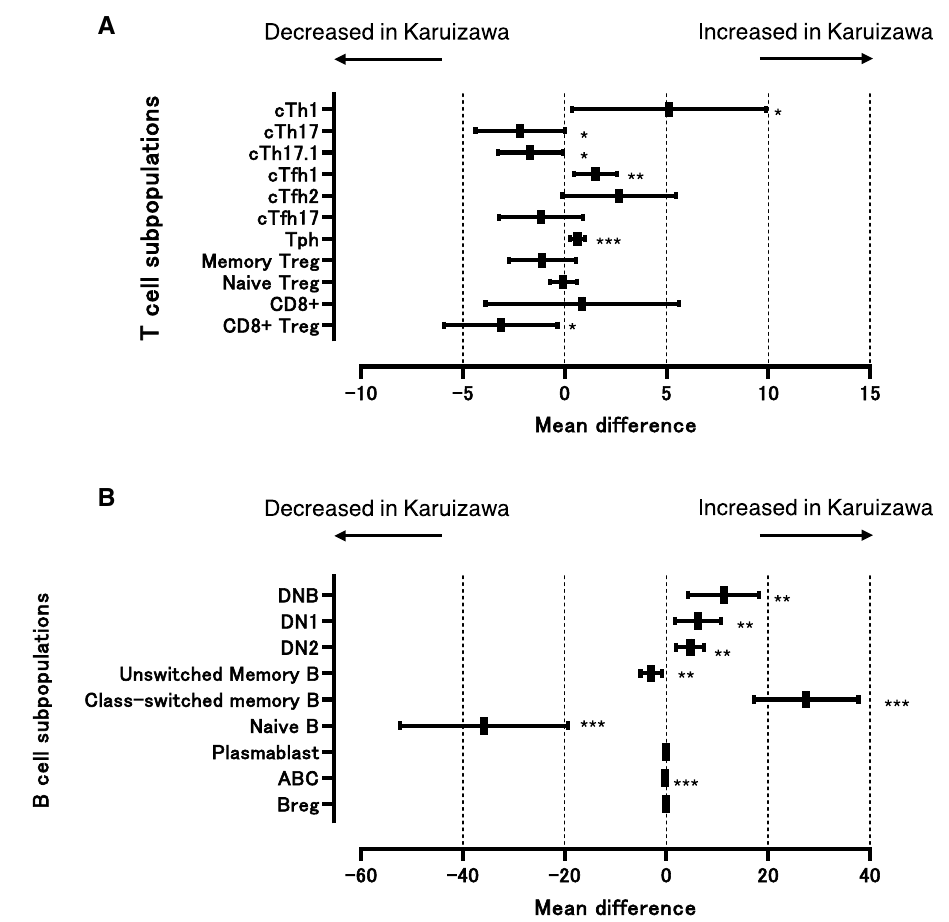
Figure 3. Comparison of subpopulations of peripheral blood T and B cells in RA patients after adjustment with propensity score weighting. Inverse probability weighting adjustments with propensity scores were performed to control for biases caused by the imbalance of potential confounding factors in comparison of subpopulation in T cells ( A ) and B cells ( B ) of PBMC collected from RA patients in two hospitals. The graph shows the mean difference with 95% confidence intervals for each subpopulation after IPW adjustment. Positive or negative numbers represent increase or decrease of the subpopulations in the patients in Karuizawa, respectively. Statistical significance was defined as * P < 0.05, ** P < 0.01, *** P < 0.001, and **** P <